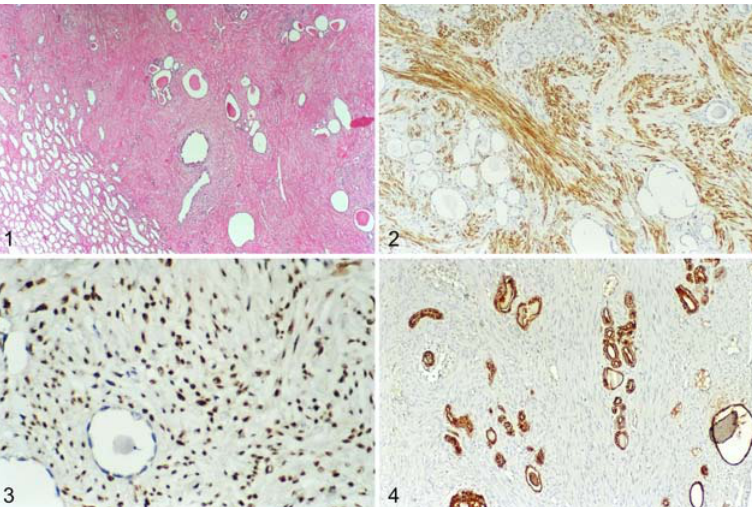
FIGURE 1. The biphasic lesion of kidney, with an adenomatous component composed of tubular structures of varying diameter dispersed throughout a predominant stromal component formed by spindle-shaped cells arranged in fascicles ( × 100, Haematoxylin & Eosin). FIGURE 2. Immunohistochemical expression of Smooth Muscle Actin in the stromal component ( × 150, SMA). FIGURE 3. Immunohistochemical nuclear positivity for Estrogen Receptor in the stromal cells ( × 200, ER). FIGURE 4. Epithelial component showing immunohistochemical expression of Epithelial Membrane Antigen ( × 100,